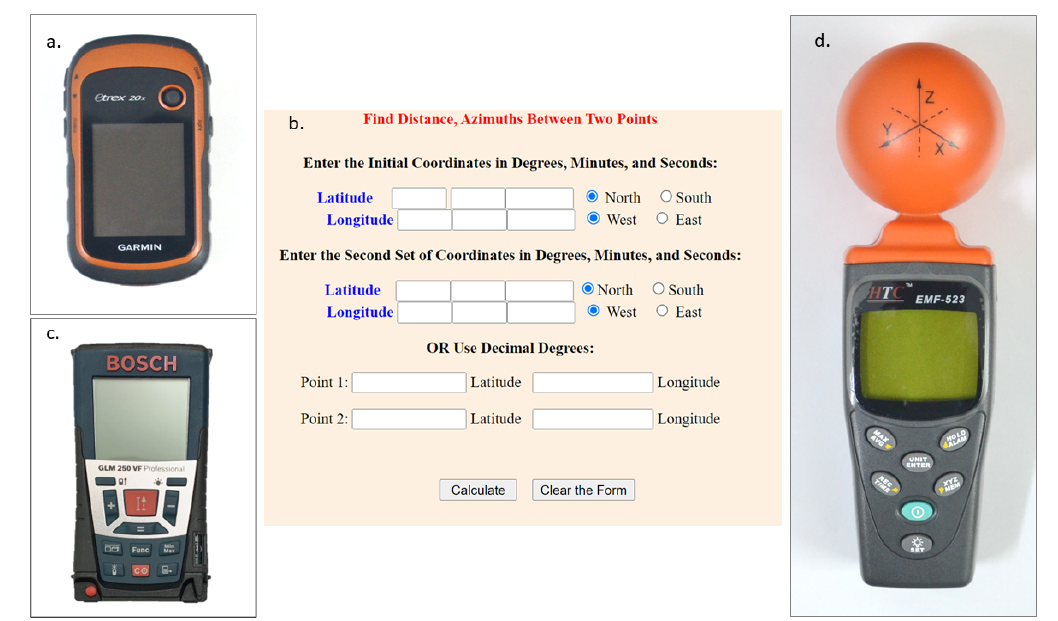
Figure 2 . ( a ) Garmin etrex 20x device to identify the cell phone tower coordinates; ( b ) FCC Online conversion tool for calculating distance between two cell phone towers based on two coordinates; ( c ) Bosch GLM 250 VF Professional range finder to measure the distance around the cell phone tower; ( d ) HTC EMF-523 to measure EF, MF and PD .